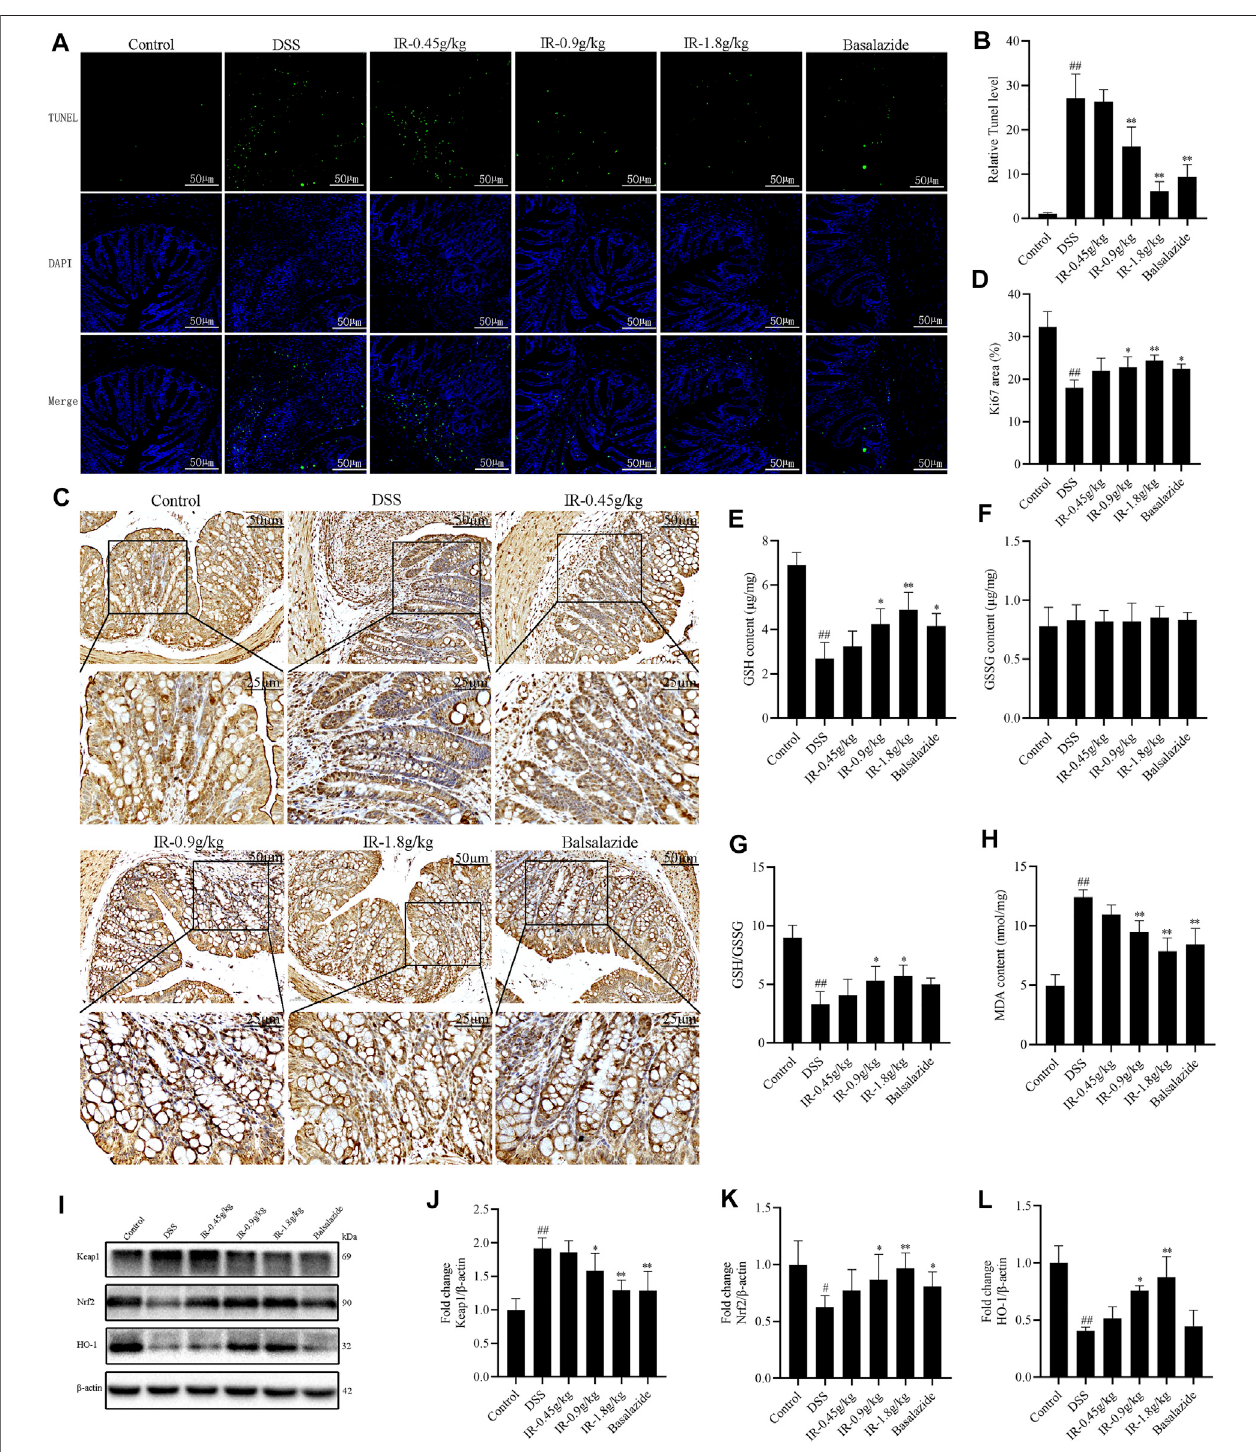
FIGURE 4 | IR alleviates the apoptosis and oxidative stress of colon tissue in UC mice. (A) Colon cell apoptosis detected by Tunel staining. (B) Positive area statistics of Tunel. (C) Colonic epithelial cell proliferation detected by Ki67 staining. (D) Histochemical positive area statistics of Ki67. (E,F) The content of glutathione (GSH)andoxidizedglutathione(GSSG). (G) TheratioofGSH/GSSG. (H) Thecontentofmalondialdehyde(MDA). (I) TheproteinlevelsofKeap1,Nrf2,andHO-1incolon detectedbywesternblotting. (J-L) ThegrayintensityanalysisofKeap1,Nrf2,andHO-1proteins,respectively.Alldatawerecomparedusingone-wayANOVA,and p -values re fl ected differences between experimental groups ( n =